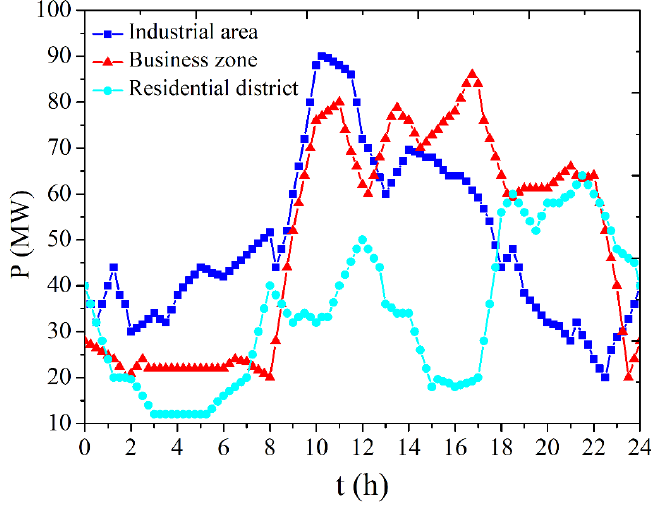
Figure 2. Daily load-curve of the divided areas.